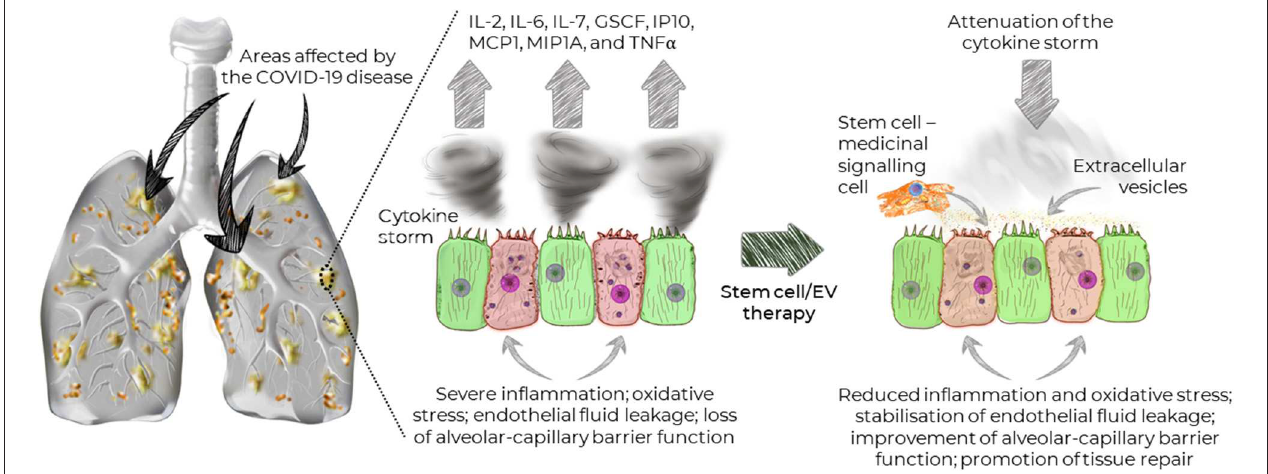
FIGURE 1 | Widespread distribution of the areas affected by COVID-19 and the effects of stem cells and extracellular vesicles on the recovery of lung function.